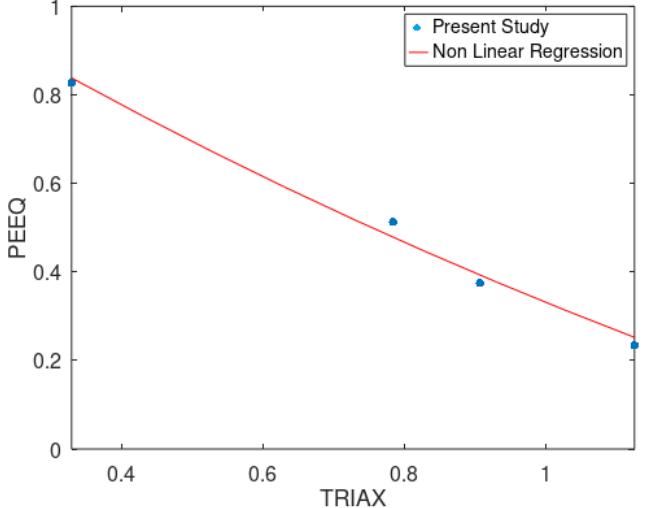
Figure 5. PEEQ versus Triaxiality curve to determine D 1 , D 2 and D 3 parameters on notched specimen. Here, the Y intercept in Equation (13) is considered as 1 to obtain the linear equation form.